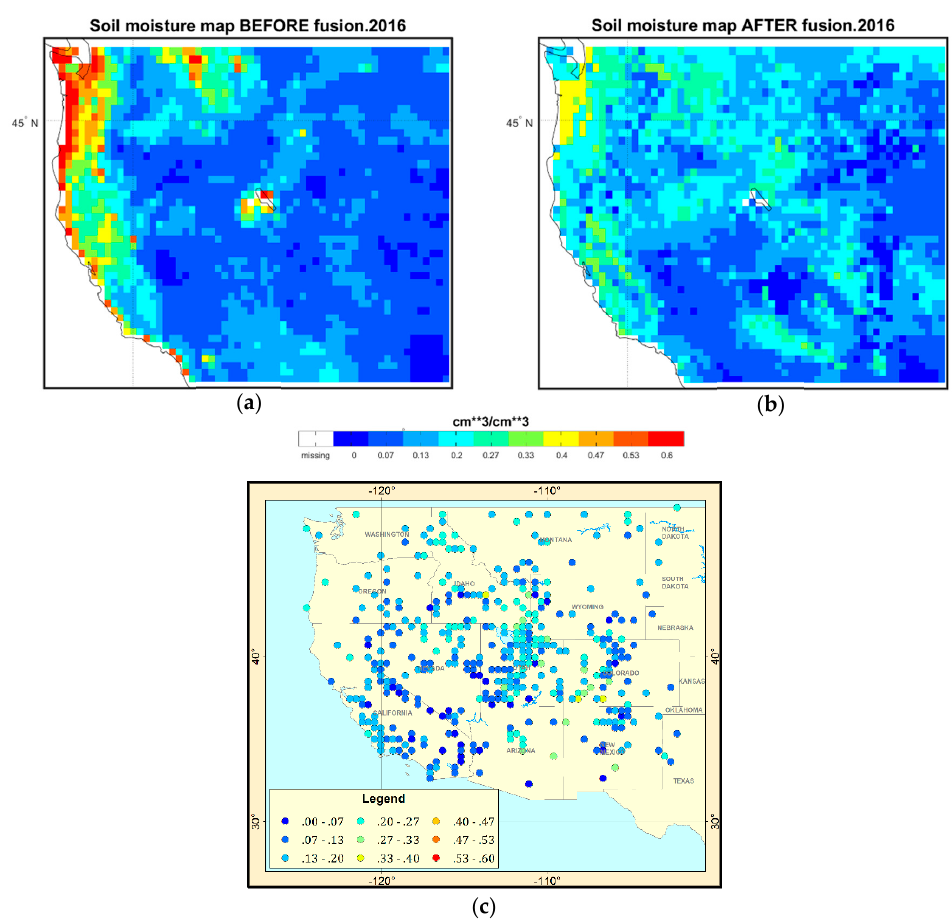
Figure 7. Annual mean SSM map of the year 2016 for ( a ) the original SMAP SSM, ( b ) the GRNN-estimated SSM, and ( c ) the site-specific SSM.